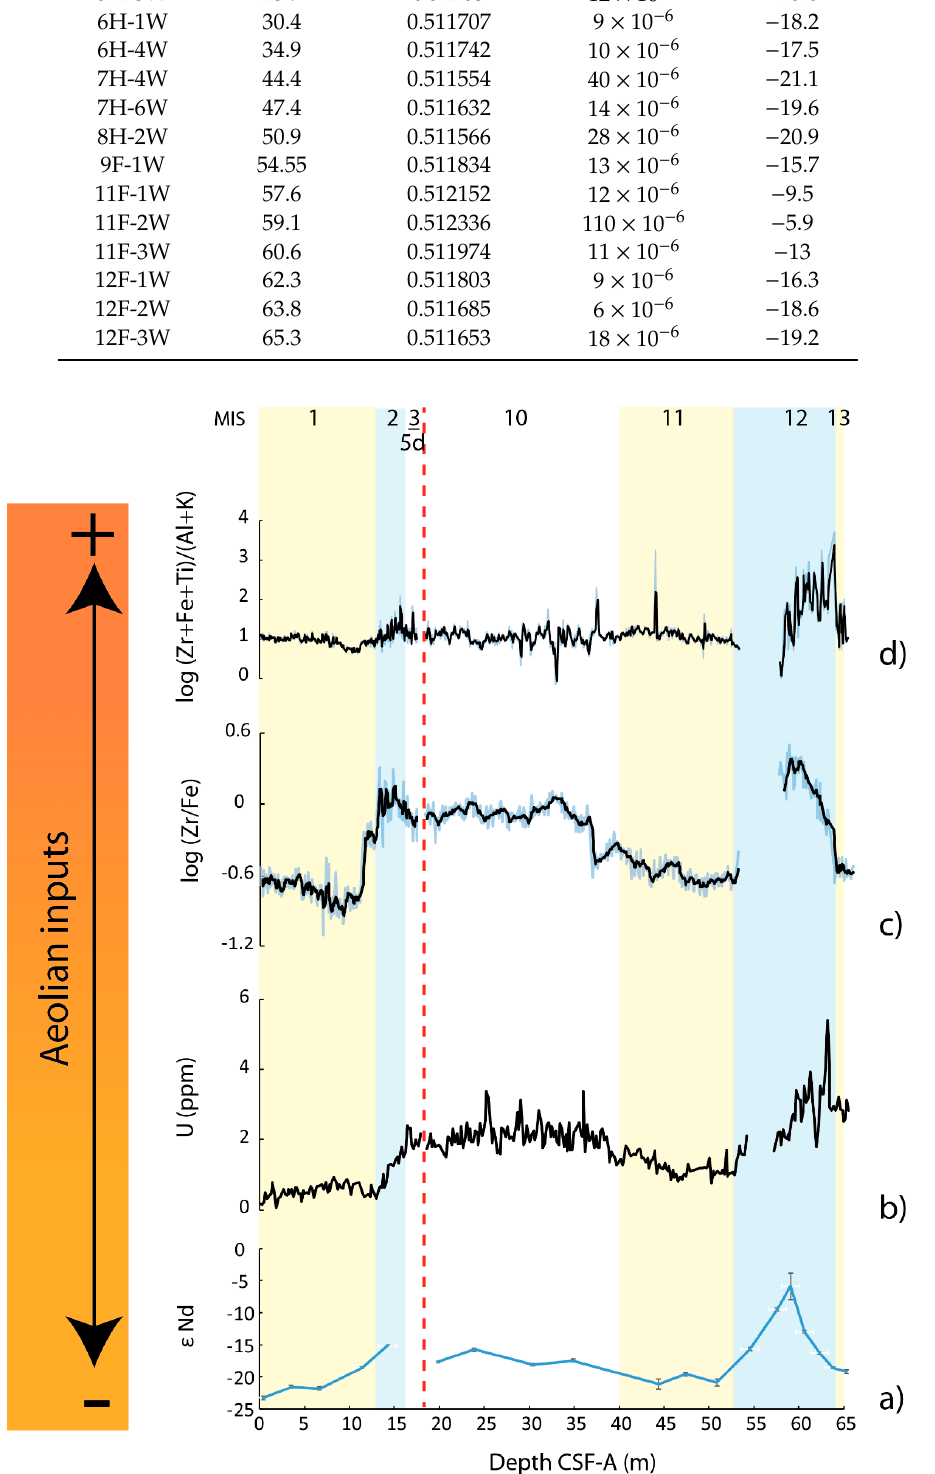
Figure 4. Proxies to trace the aeolian inputs. ( a ) ε Nd, ( b ) uranium concentration (ppm), ( c ) log(Zr/Fe), and ( d ) log(Zr + Ti + Fe)/(Al + K). Black lines are the moving average with a period of 5 for ( c , d ). The log (Zr/Fe) follows the U concentration plot (Figure 5c). It shows low values during the MIS 13, with an average of − 0.6, but very high values during the MIS 12, with a peak at 59 m (0.5). At the m reaches the value of − 0.2. Through MIS 10, the values remain steady with an average of 0. During